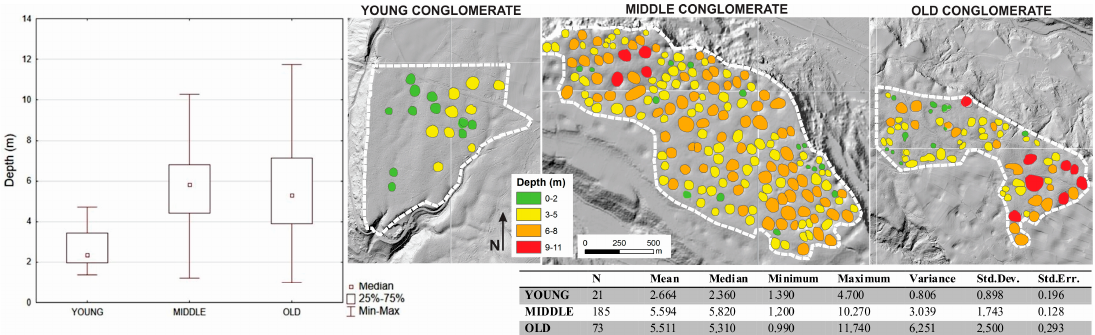
Figure 14. Doline depth for conglomerates by age.